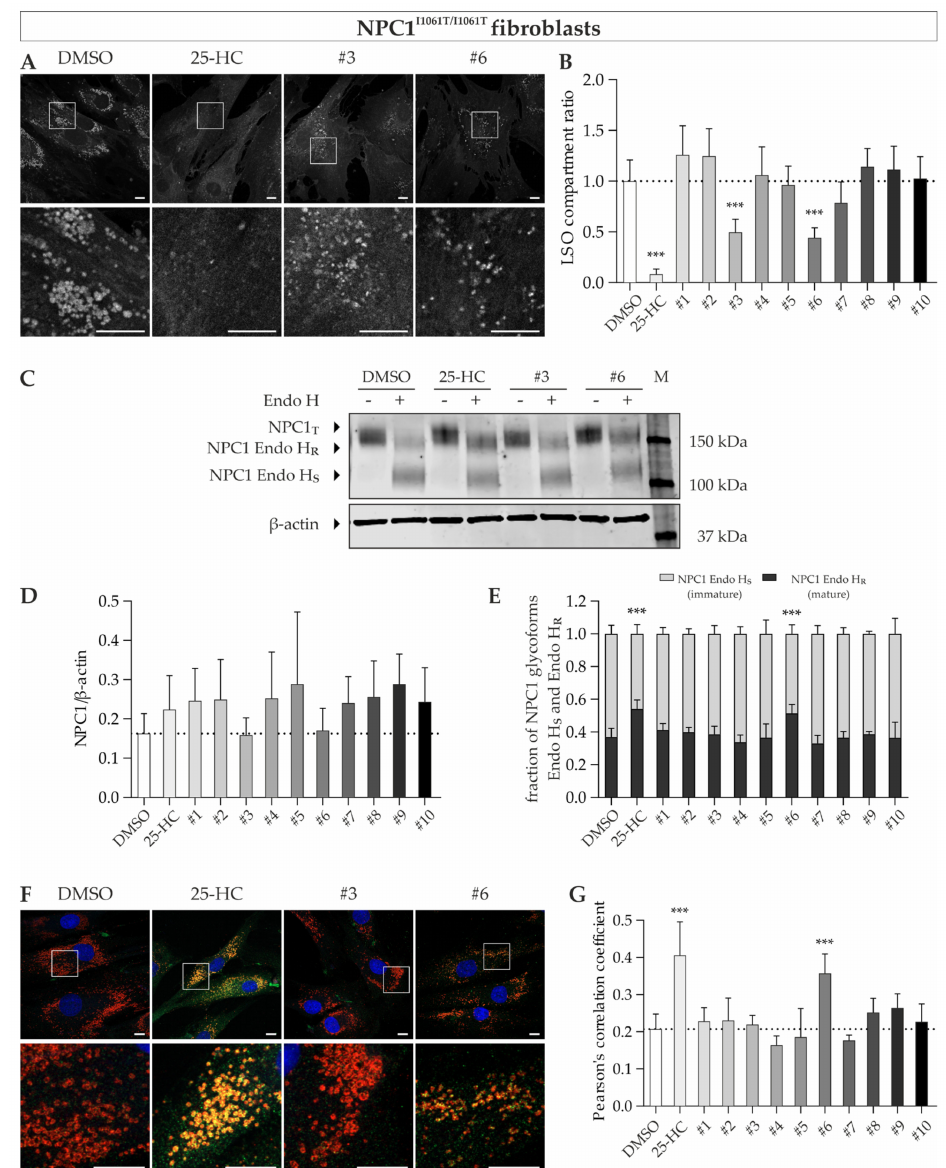
Figure 6. Treatment of NPC1 I1061T/I1061T fibroblasts with potential pharmacological chaperones. ( A ) Representative images of filipin-stained NPC1 I1061T/I1061T fibroblasts. ( B ) Quantification of LSO compartment ratio reveals decreased cholesterol content upon treatment with 25-HC, quinestrol (#3), and abiraterone acetate (#6). N = 8. ( C ) Representative image of Western blot analysis to determine total NPC1 protein (NPC1 T ) and post-ER glycoform of NPC1 protein (Endo H R ). ( D ) Treatment with compounds did not lead to a change of NPC1 T levels. N = 4–11. ( E ) The Endo H-resistant and Endo H-sensitive glycoforms of NPC1 protein are indicated as a fraction of total NPC1 (Endo H R + Endo H S ). Determination of NPC1 glycoforms revealed an increase of Endo H R portion upon treatment with 25-HC or abiraterone acetate (#6), indicating an ameliorated folding of NPC1 protein. N = 4–8. ( F ) Confocal images of immunofluorescence staining for NPC1 (green) and LAMP2 (red) in fibroblasts. DAPI was used to counterstain nuclei (blue). ( G ) Treatment with 25-HC or abiraterone acetate (#6) leads to a significant increase of NPC1 in lysosomes, as shown by increased PCC. N = 8. Scale bar = 10 µ m. *** = p < 0.001 by one-way ANOVA, followed by Dunnett’s post hoc test compared to DMSO vehicle control. NPC1 T = total NPC1 protein; Endo H = Endoglycosidase H; Endo H R = Endo H-resistant; Endo H S = Endo H-sensitive; M = size